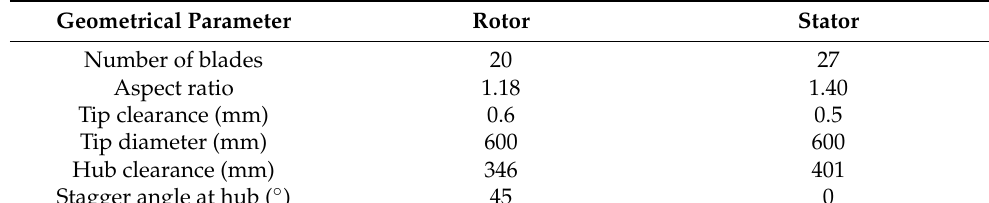
Table 2. The structural design parameters of TA36 [41].